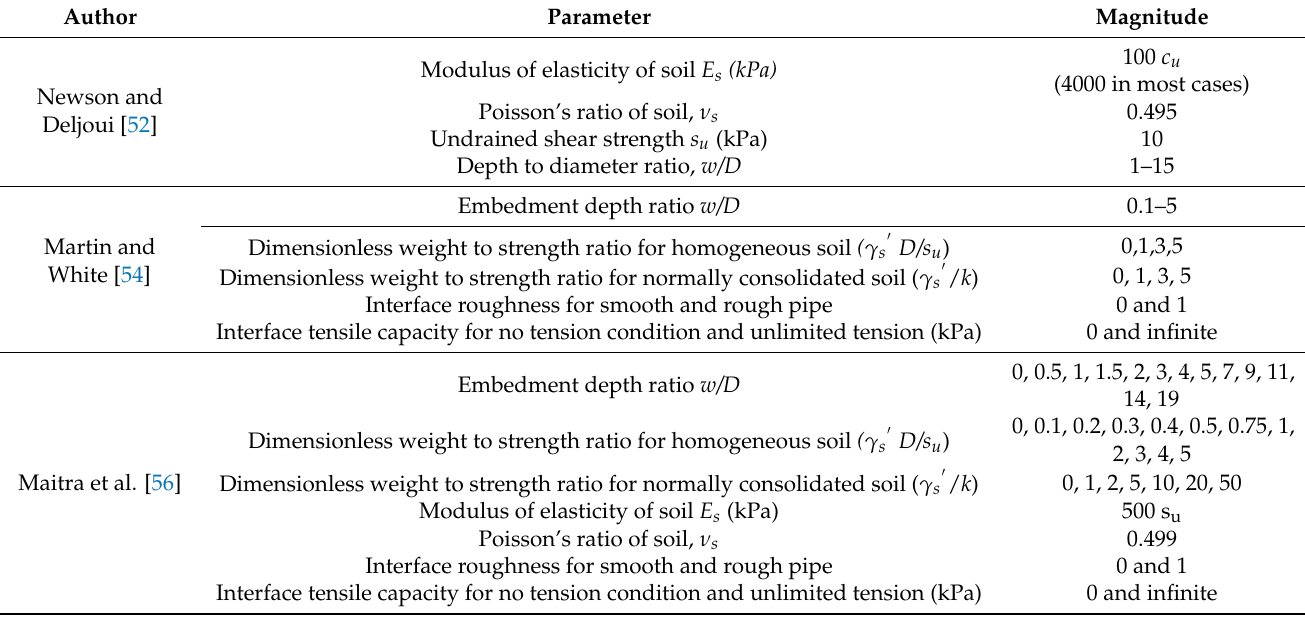
Table 3. Parameter used in the Numerical models for uplift resistance of buried